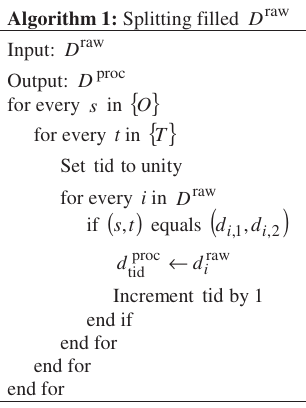
Figure 2: Pseudo Code for the Splitting